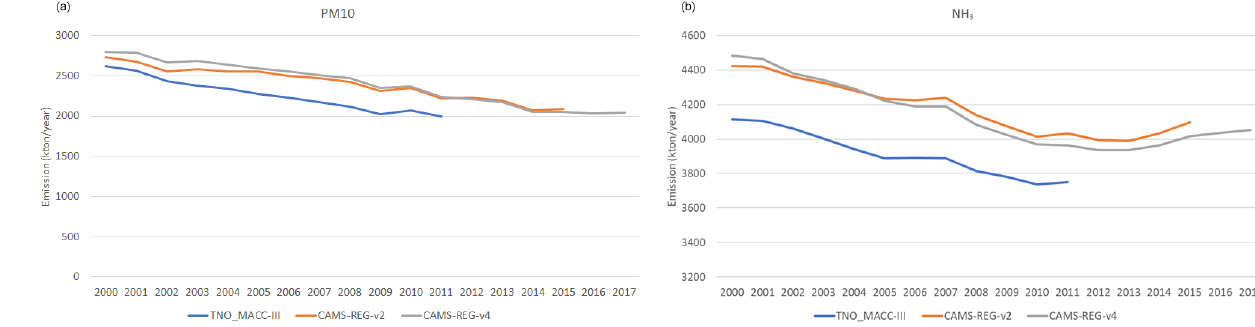
Figure 8. Comparison between CAMS-REG-v4.2 and its predecessors (TNO_MACC-III and CAMS-REG-v2.2.1) for EU + as a whole for PM 10 (a) and NH 3 (b) .